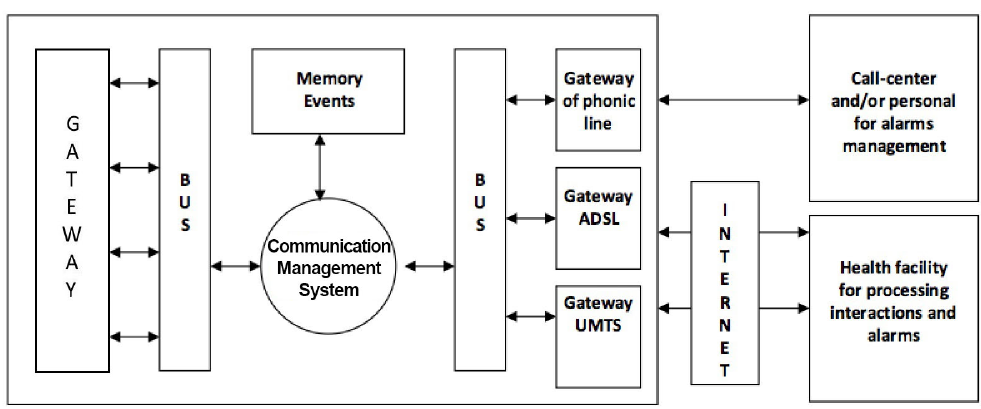
Figure 5. Block diagram of communication interfaces towards the outside (ref. Figure 2,